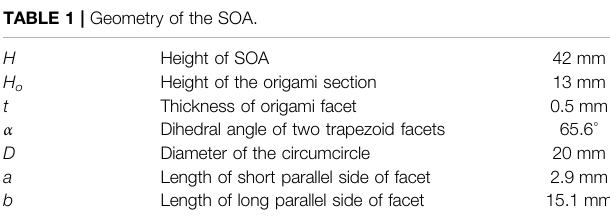
TABLE 1 | Geometry of the